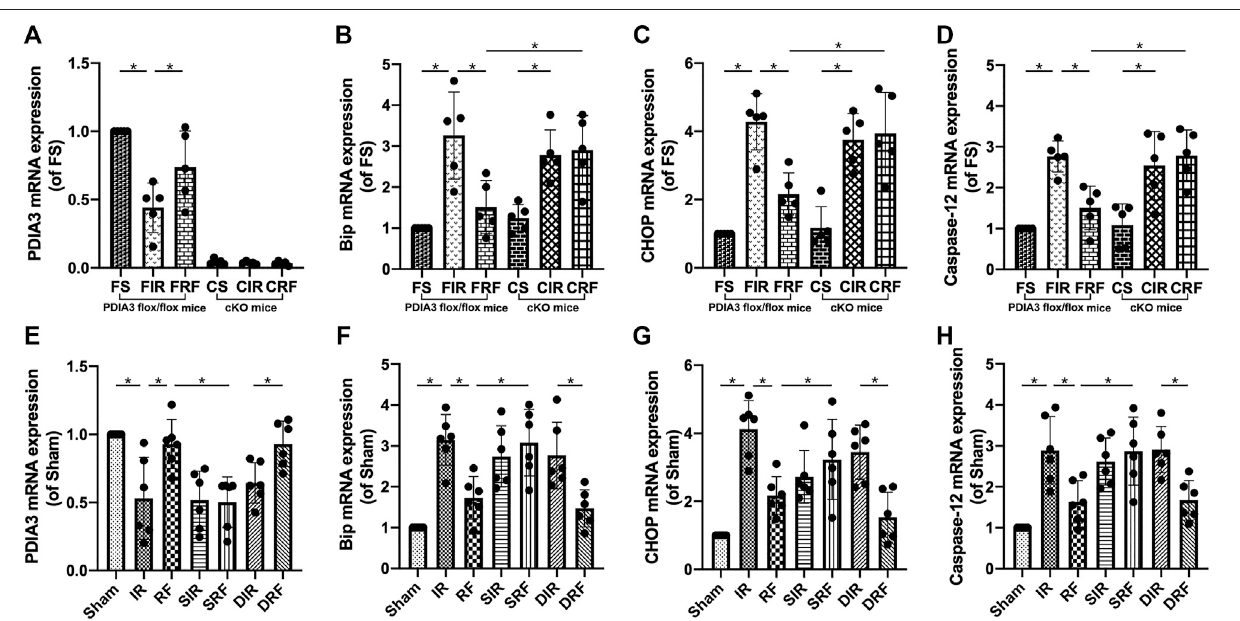
FIGURE4| ChangesinintestinalmRNAexpressionoftherelevantproteins.Groupsarethesameasin Figure1 .ThechangesinPDIA3,Bip,CHOP,andcaspase- 12 mRNA levels in the intestine are shown in (A – H) ( n = 5 – 6). Data are expressed as mean ± SD. The results were compared by ANOVA with Tukey ’ s post hoc test. * P <